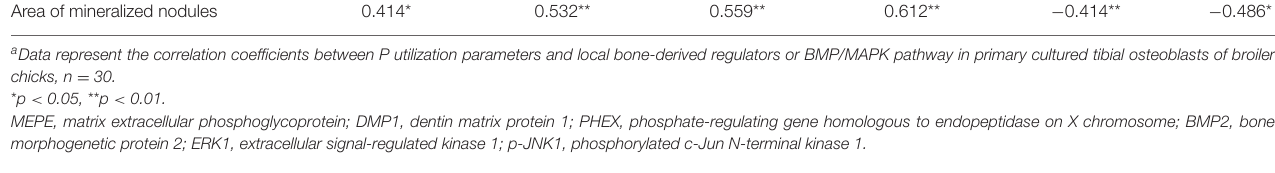
TABLE 2 | The correlation coefficients between P utilization parameters and local bone-derived regulators or BMP/MAPK pathway in primary cultured tibial osteoblasts of broiler chicks a . Items